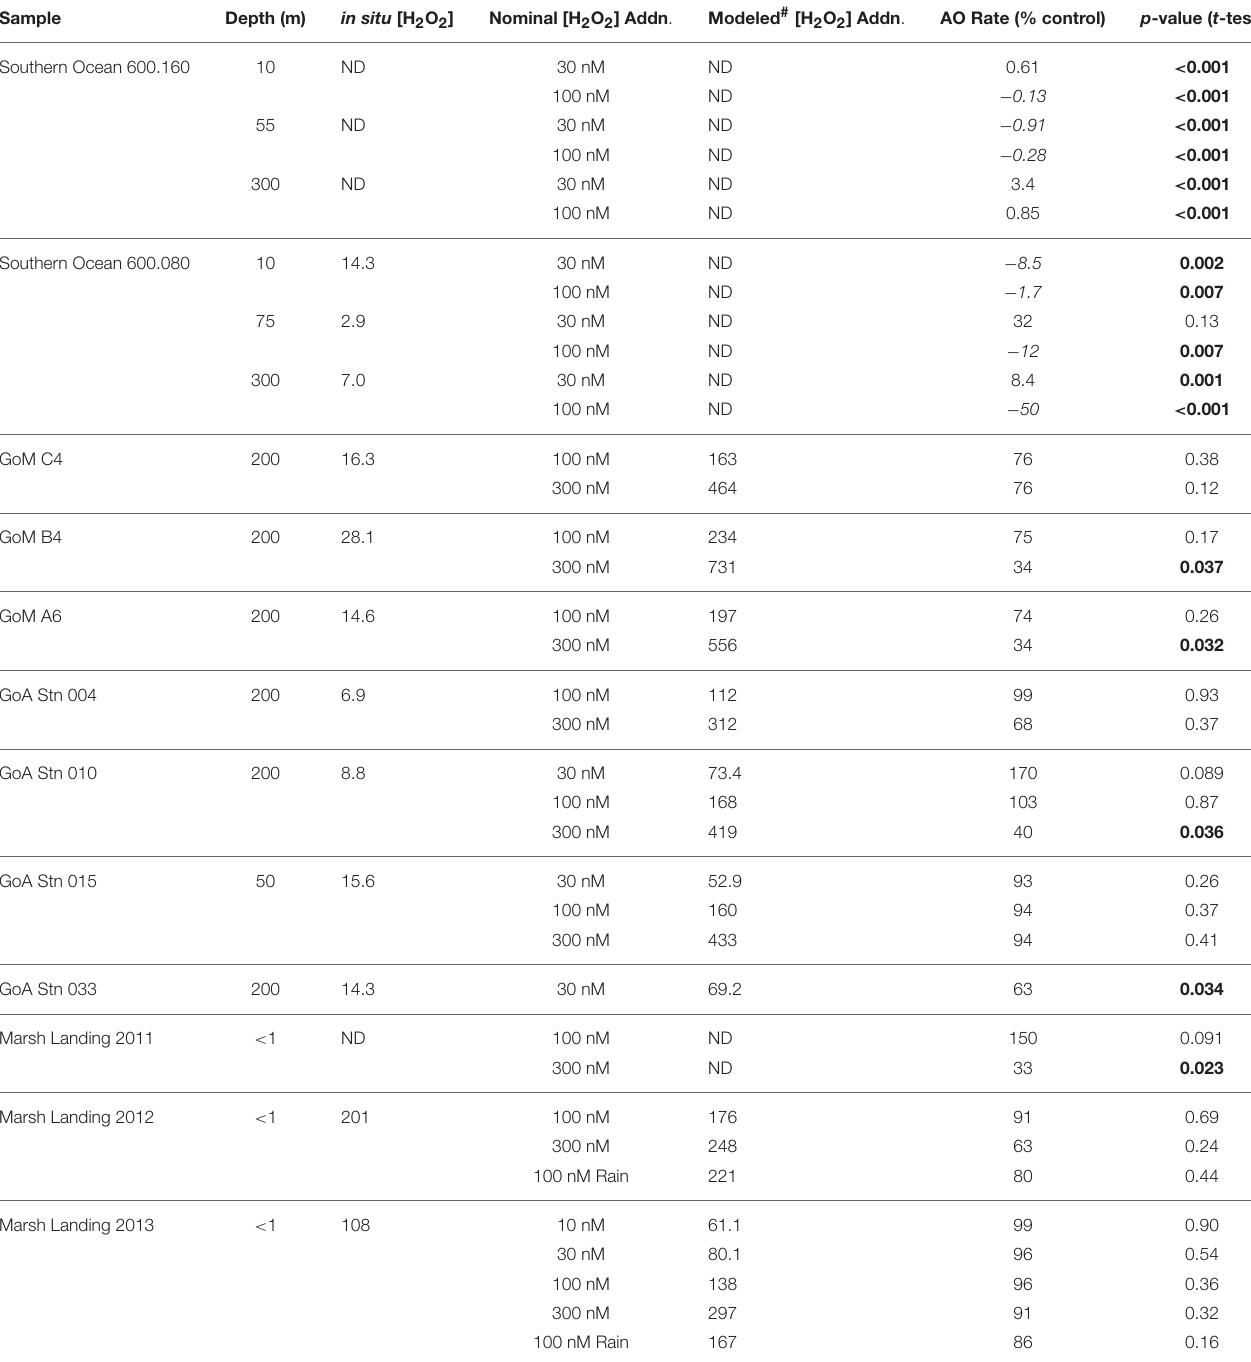
TABLE 1 | Summary of ROS incubation